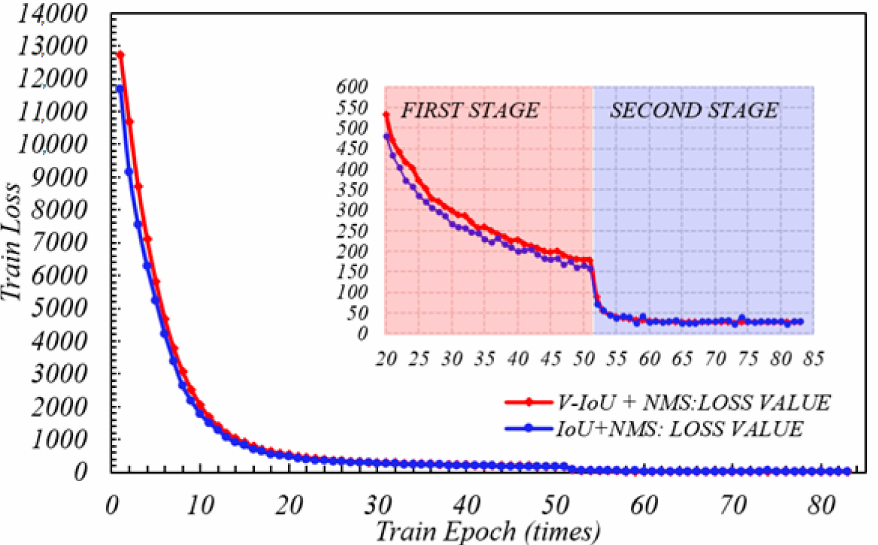
Figure 9. V-IoU versus IoU training loss (epoch: 0 to 83).